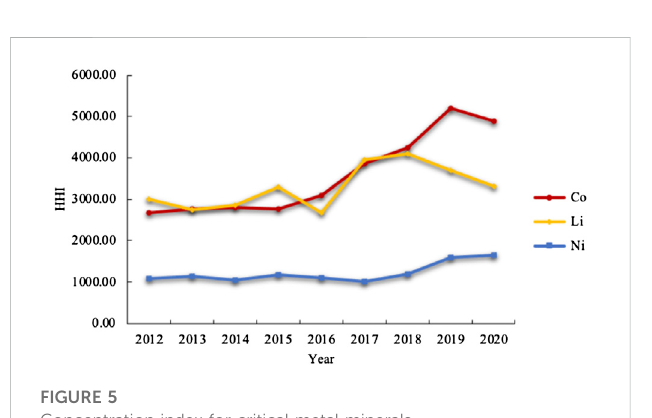
FIGURE 5 Concentration index for critical metal minerals.